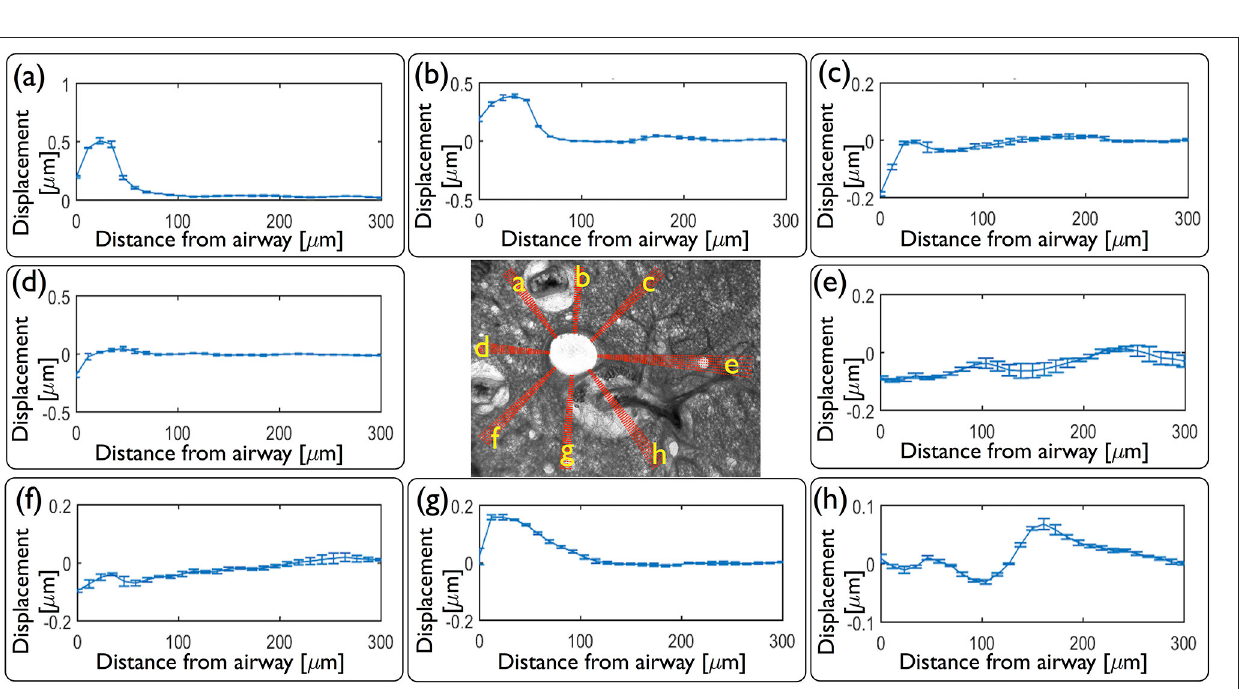
FIGURE 6 | Local quantitative analysis of the mouse lung slice (central image) from Figure 1 at peak contraction following application of agonist. Inward radial displacements are plotted as a function of distance from the airway lumen for each of the eight sets of independent spokes (a – h) shown on the central image. Spokes a , b , and g go through the highly collagenous part on the edge of a blood vessel; spokes c , d , and f go through alveolar tissue, spoke e intersects another small contractile airway and h goes through a blood vessel.